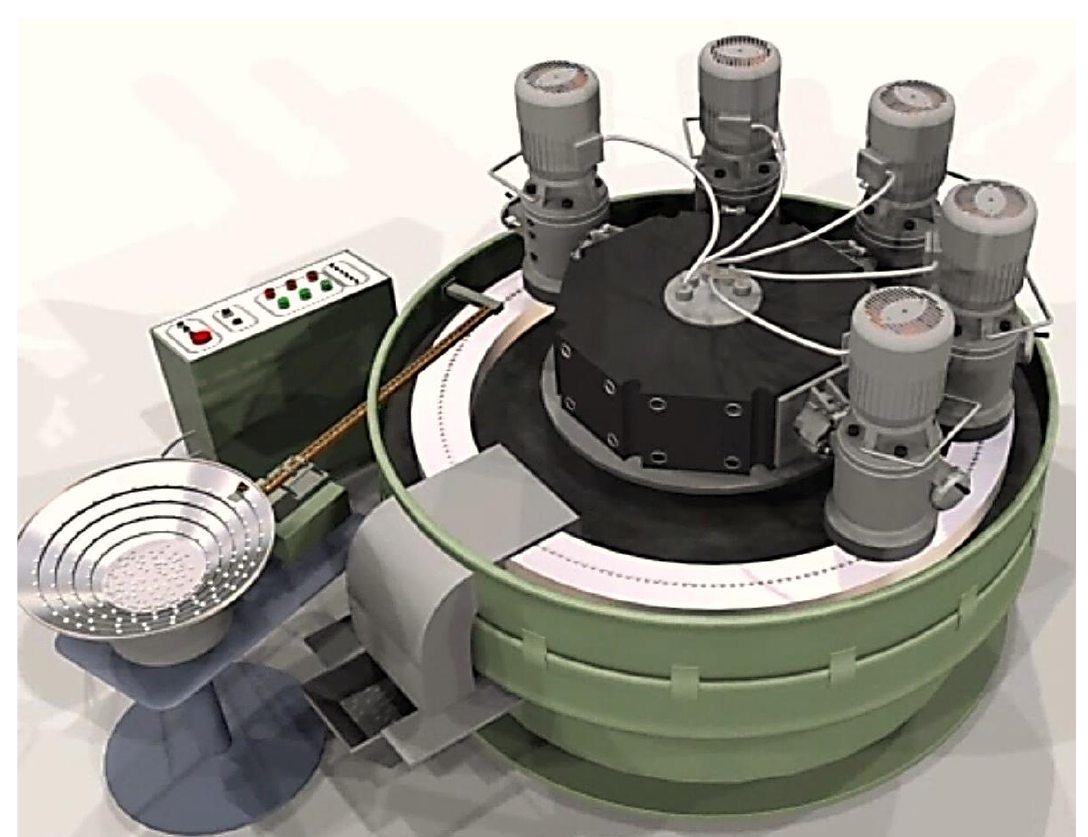
Figure 12. Automatic grinding machine for processing small ceramic parts (as one of a series of devices designed and made in the Department of Technical and Information Systems of Koszalin University of Technology).